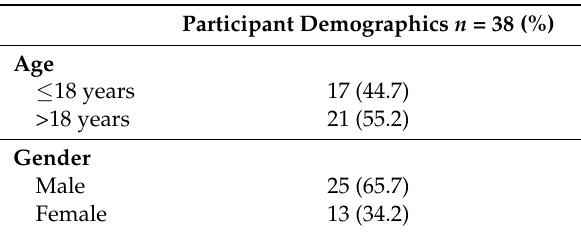
Table 1. Age and gender distributions of study participants.